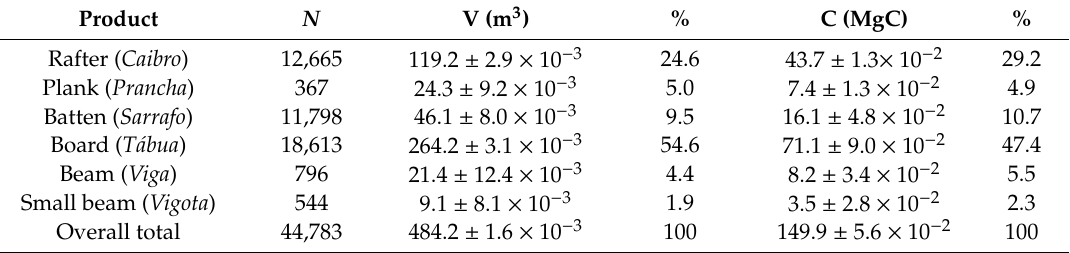
Table 5. Number of pieces (N), volume of sawn wood by type of product (V, in m 3 ), and carbon stored in sawn wood by product type (C, in MgC) (mean ± standard error of the mean) for commercial sawn-wood end products from 12 species in a 1252.8-ha area harvested in a forest-management area in the state of Acre,